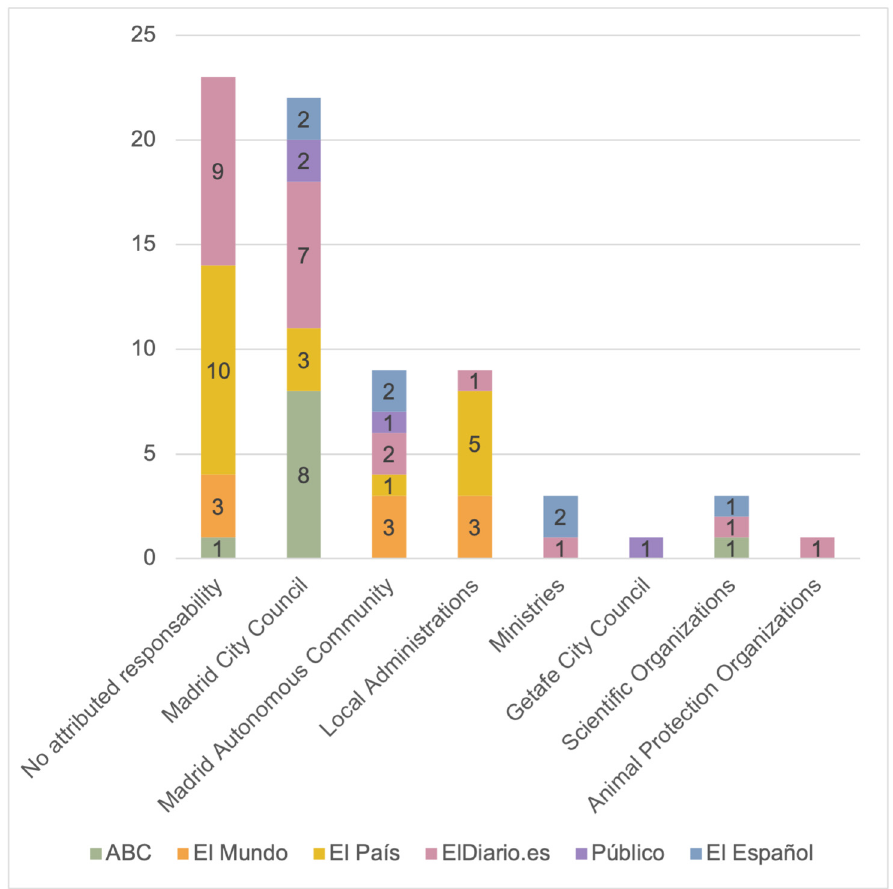
Figure 2. Attributed responsibility for population management of monk parakeets in the analyzed articles. Source: Own elaboration from texts from El País , El Mundo , ABC , elDiario.es , Público , and El Español .